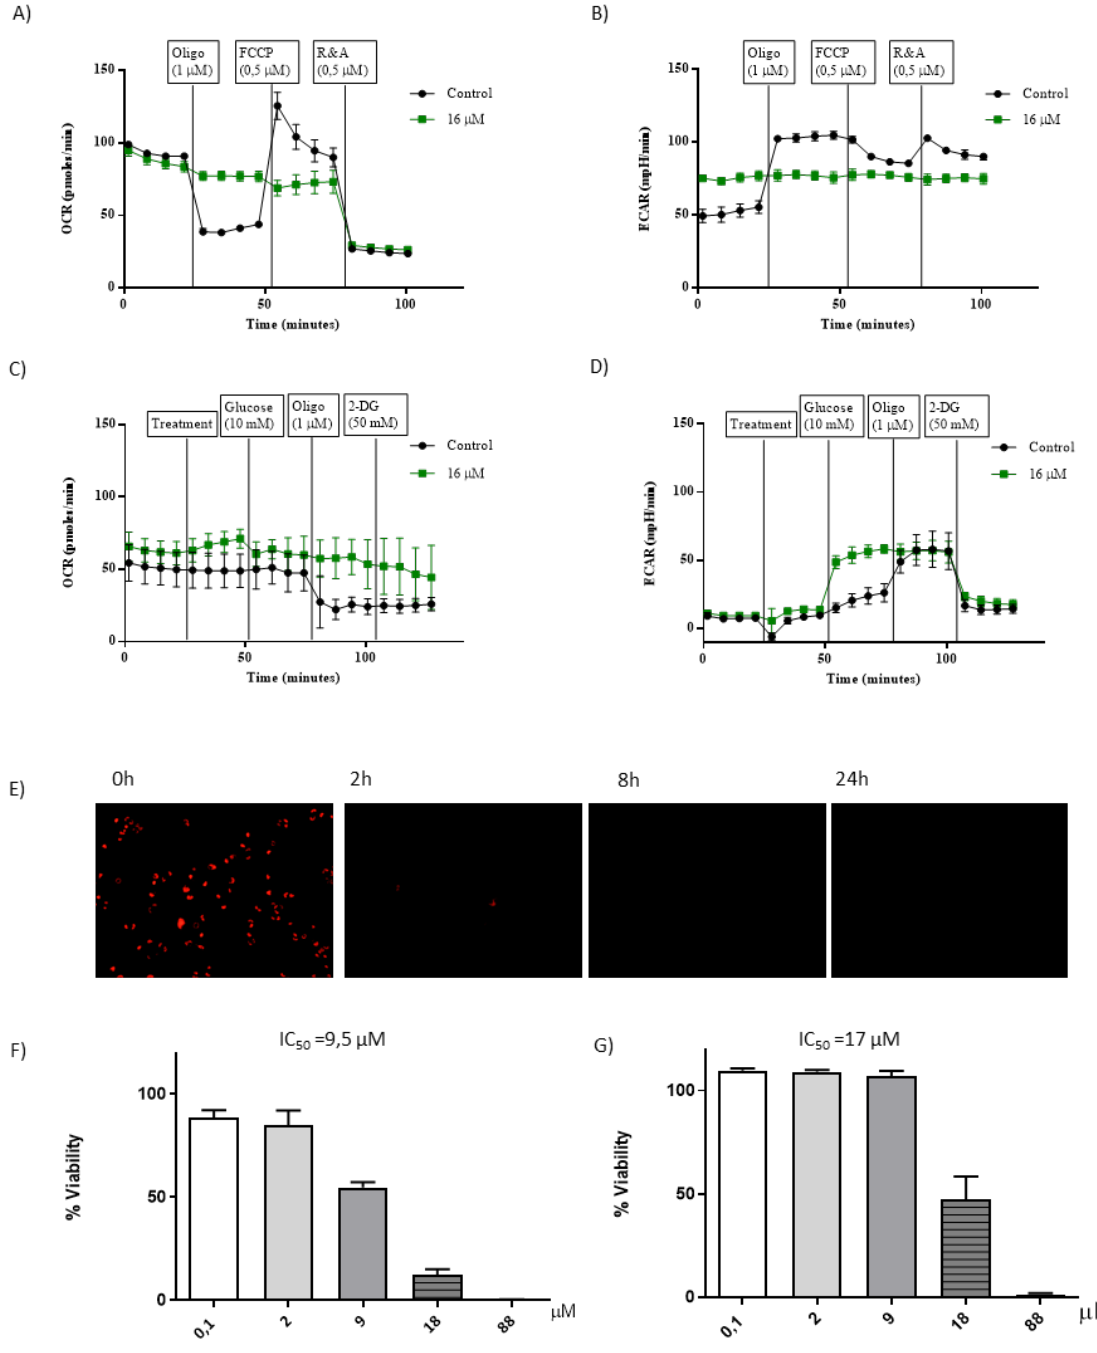
Figure 7. OCR ( A ) and ECAR ( B ) profile of A549 cells, incubated for 1 h with 1[C,NH] (16 µ M) or vehicle (control). ( C ) OCR and ( D ) ECAR profile of A549-gal incubated with (treatment) 1[C,NH] (16 µ M) or vehicle (control). Seahorse images are representative of three independent experiments. ( E ) A549 cells were pre-stained with TMRM (50 nM) and treated with 16 µ M of 1[C,NH] . Images (10×) were obtained at indicated incubation times after the treatment. Percentage of viability of A549 proliferant cells ( F ) and A549 quiescent cells ( G ), after 24 h of incubation at different concentrations of 1[C,NH] . Data shown are the mean and SD of at least three independent experiments.